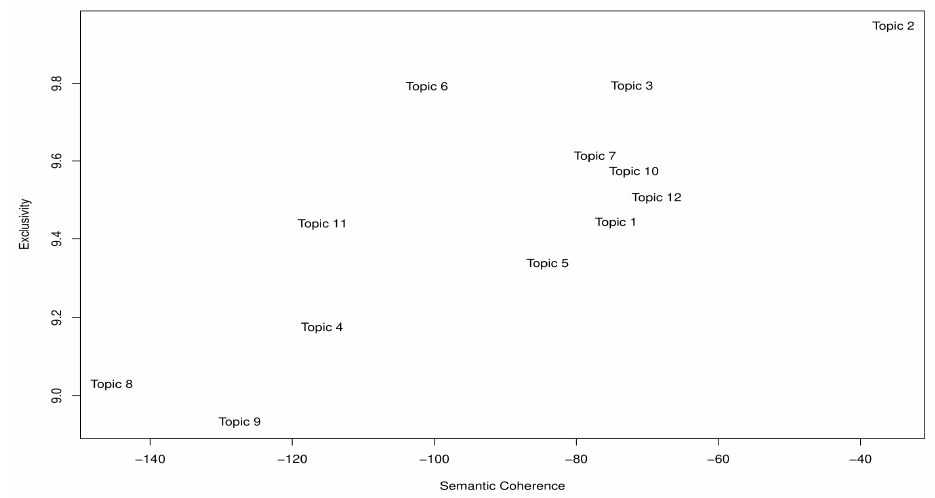
Figure A5. Plots result pf the selected model semantic coherence and exclusivity for each 12 topics.